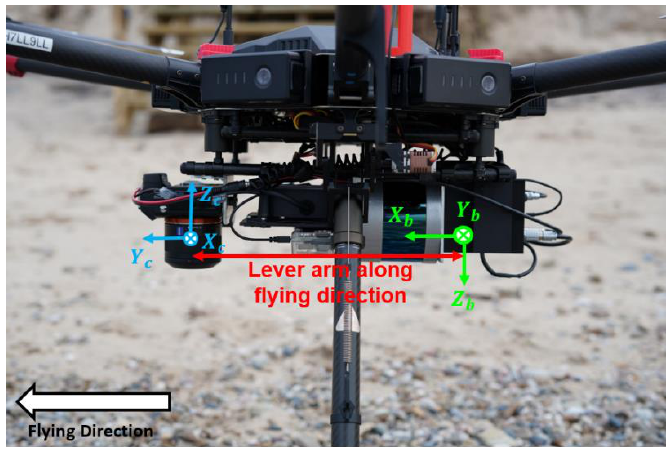
Figure 6. Illustration of where measurements are taken to acquire the nominal lever arm values.